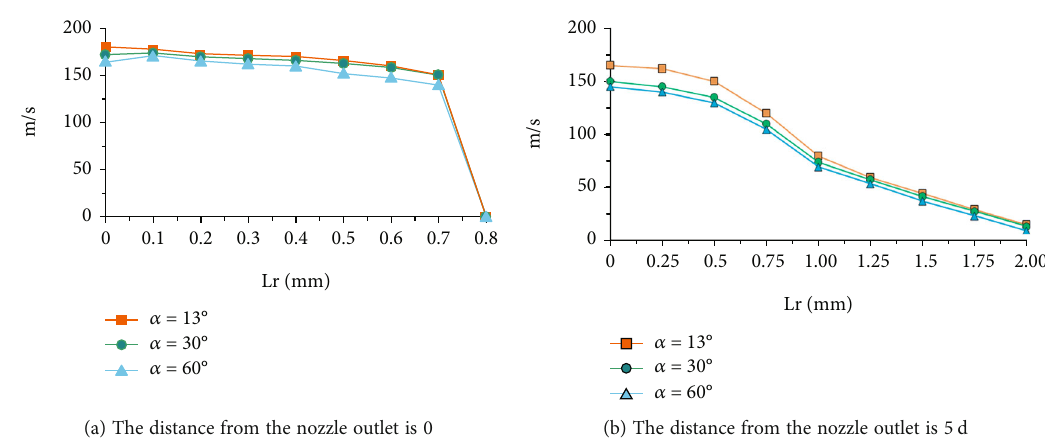
Figure 7: Velocity distribution of the water jet on the vertical axis.